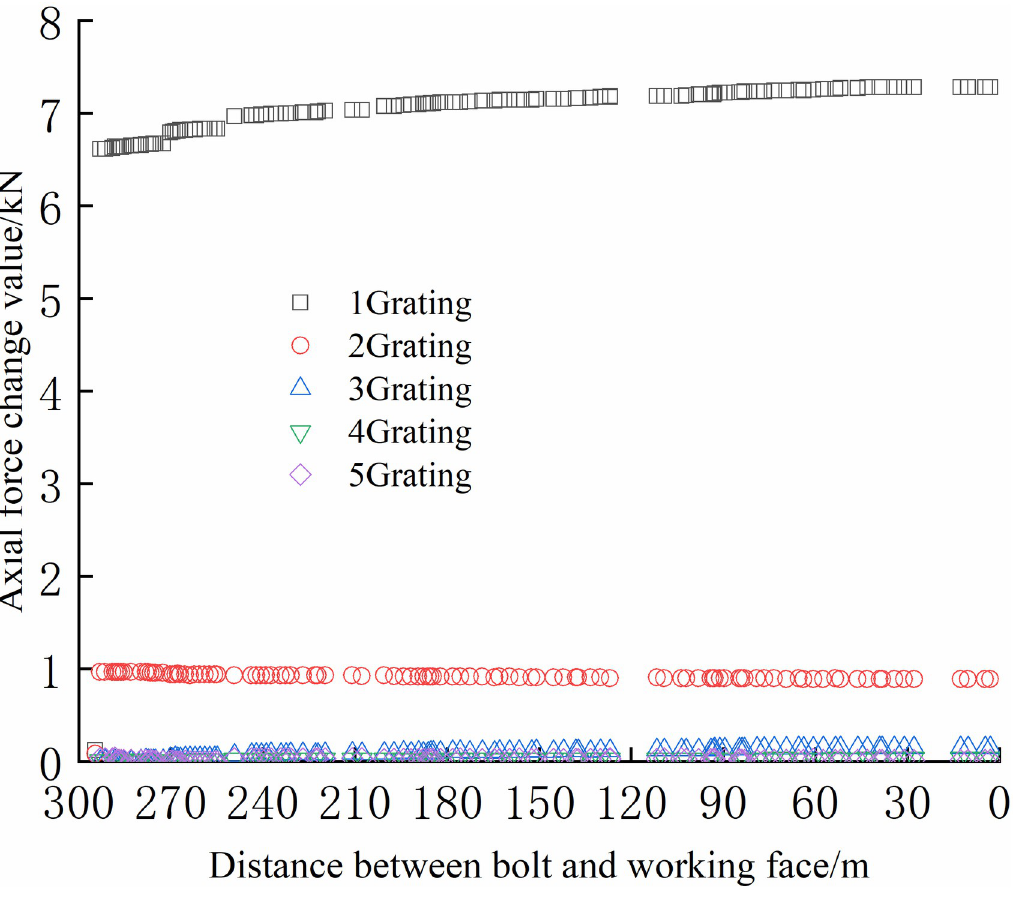
Fig 33. Axial force monitoring test curve of No. 10 bolt.